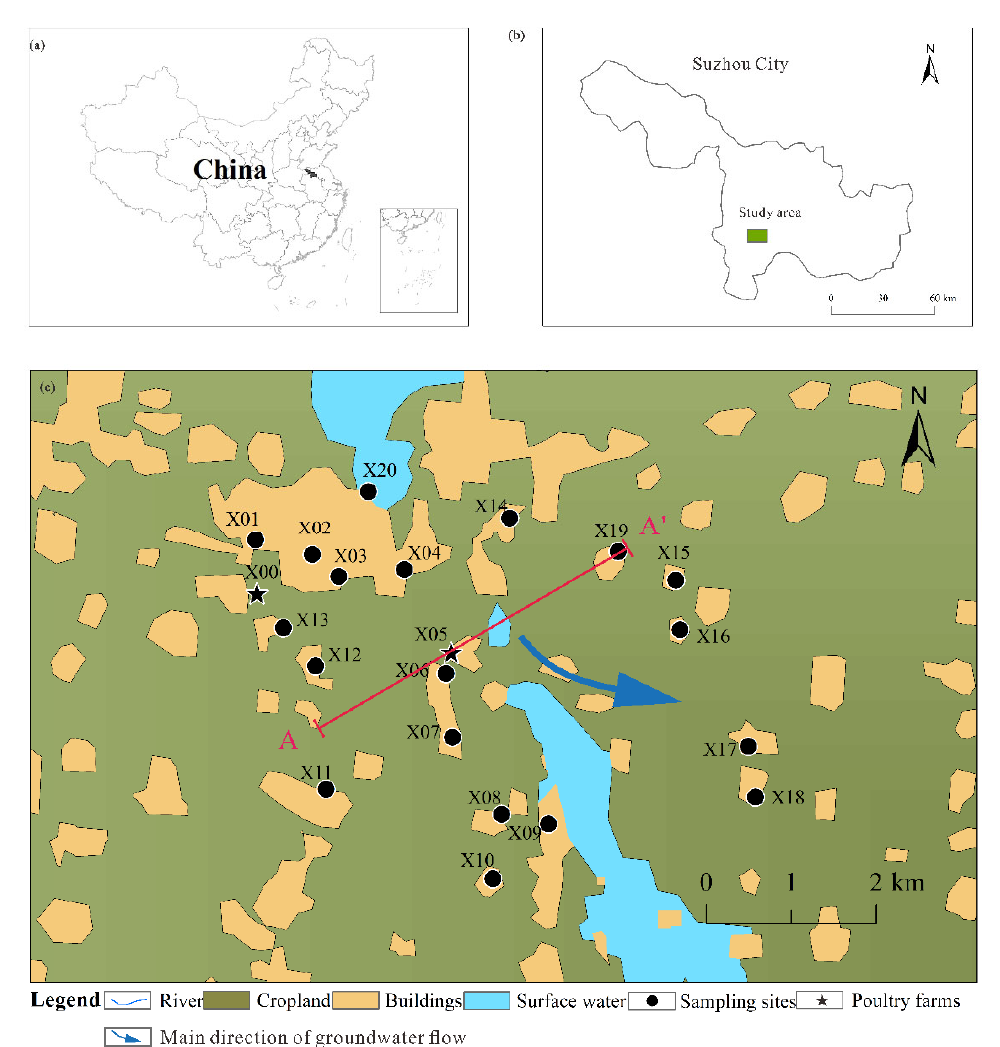
Figure 1. Location of study area and distribution of water sampling points. ( a ) China; ( b ) the location of study area; ( c ) the location of sampling points and land use.